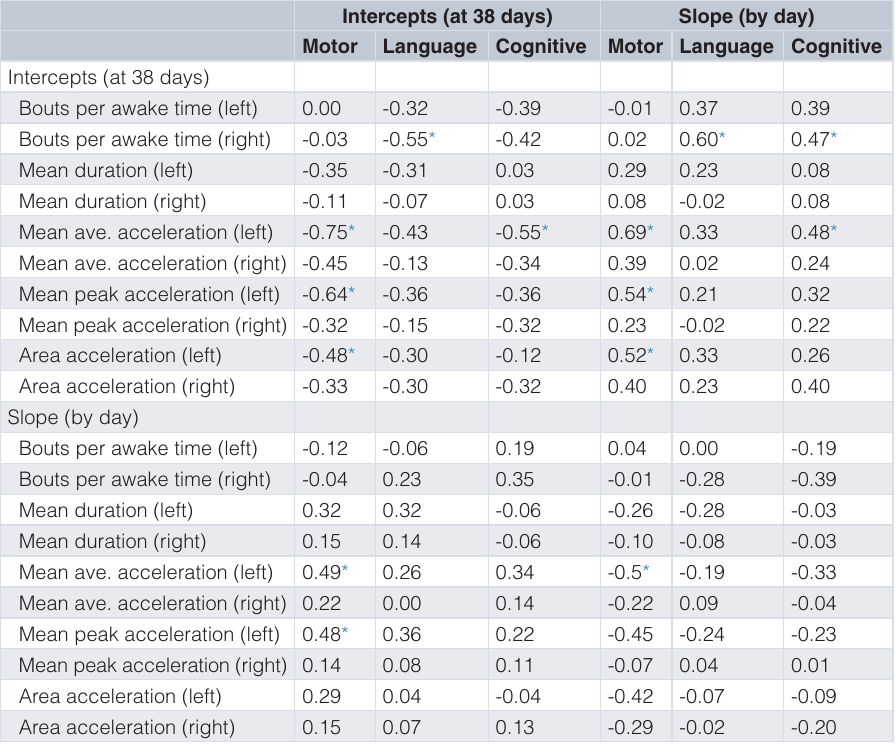
Table 2. Correlations between arm movement variables and Bayley composite score intercepts and slopes. Intercepts (at 38 days) Slope (by day) Motor Language Cognitive Motor Language Cognitive